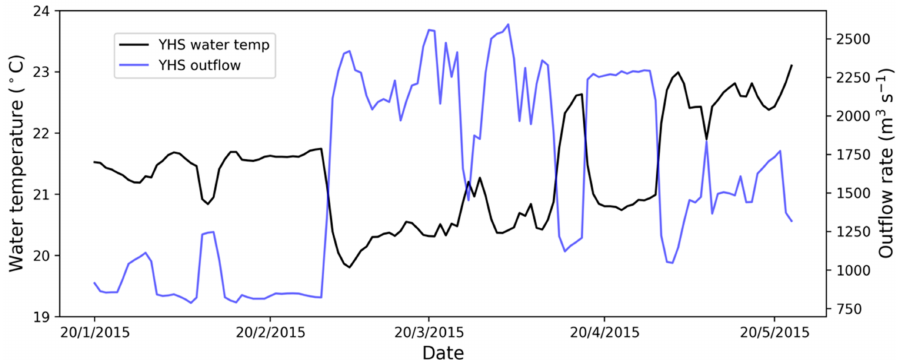
Figure 3. Comparison of the observed YHS water temperature and the YHS discharge